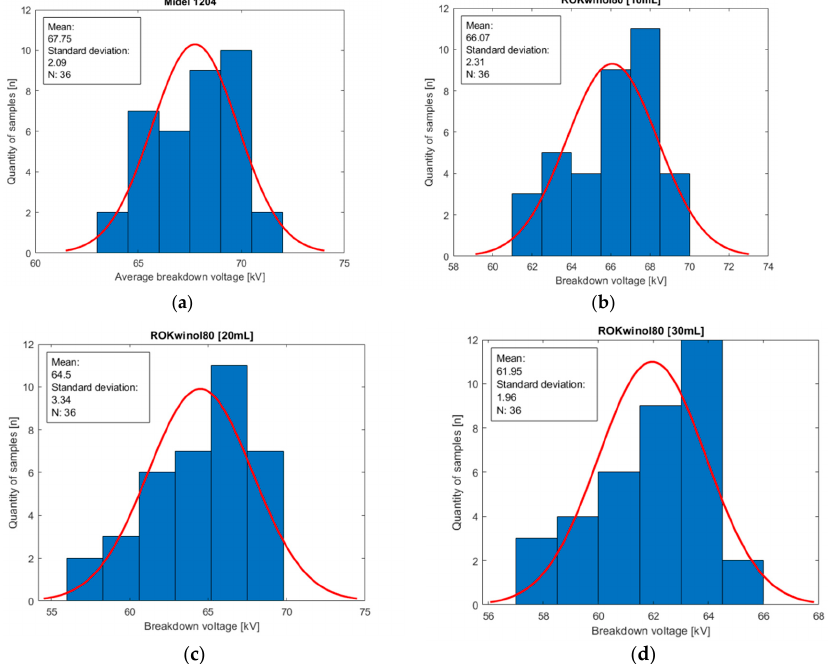
Figure 10. Histograms of oil population Midel 1204 with different concentrations of surfactant ROKwinol80 : ( a ) base sample of Midel 1204 ; ( b ) 10 mL of surfactant ROKwinol80 in a sample; ( c ) 20 mL of surfactant ROKwinol80 in a sample; ( d ) 30 mL of surfactant ROKwinol80 in a sample.